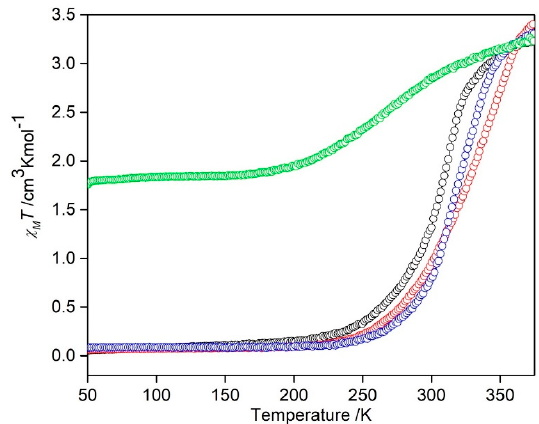
Figure 7. VSM profiles of fac -[Fe(4-ima-Bp) 3 ](Y) 2 · sol as χ M T vs. T plots of a) 1 (green), b) 2 (red), c) 3 (blue) and d) 4 (black).